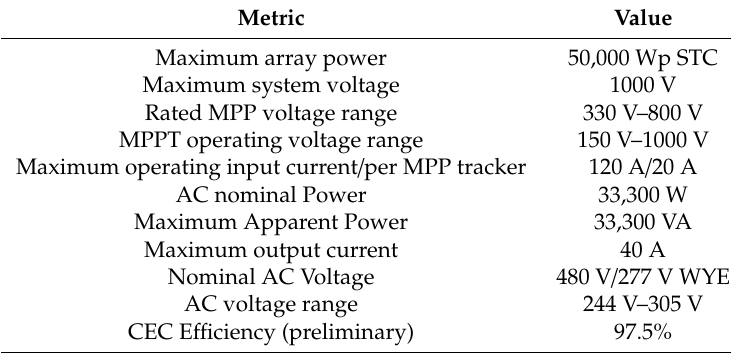
Table 2. Sunny Tripower Core1 (STP-33-US-41) inverter specifications [42].